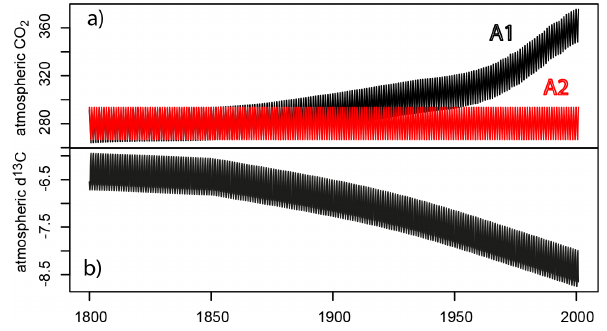
Figure 5. Daily atmospheric CO 2 (a) and δ 13 C (b) data used in the inversion. The A1 (black) scenario is a realistic one while scenario A2 (red) describes a hypothetical case where CO 2 concentrations have remained at preindustrial (1850)